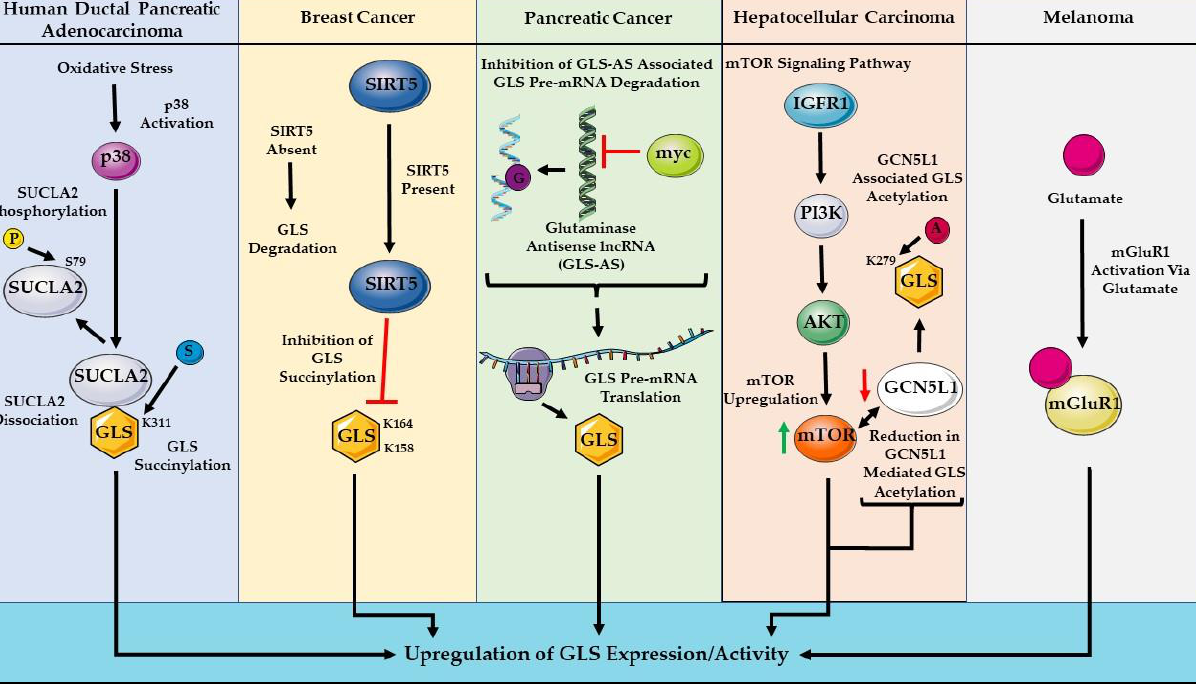
Figure 4. Known regulators of GLS expression/activity in different cancers. Symbols P, S, A, and G represent phosphate, succinyl, acetyl group, and GLS-AS protein, respectively. The black arrows indicate the series of events occurring in the cellular signaling pathways in various cancer types leading to the upregulation of GLS expression/activity. The red arrow next to GCN5L1 indicates a decrease in activity. The green arrow next to mTOR indicates upregulation. Brackets have been used to connect two different interdependent pathways. Abbreviations: succinate-CoA ligase ADP-forming subunit beta (SUCLA2), glutaminase (GLS), sirtuin-5 (SIRT5), glutaminase antisense lncRNA (GLS-AS), insulin-like growth factor receptor 1 (IGF-R1), and general control of amino ac- id synthesis 5 like protein 1 (GCN5L1). Parts of the figure were created using pictures from Servier Medical Art. Servier Medical Art by Servier is licensed under a Creative Commons Attribution 3.0 Unported License (https://creativecommons.org/licenses/by/3.0/, accessed on 9 June 2022. 6. Discussion and Future Directions mGluRs have been extensively studied in the CNS, with vast numbers of agonists and antagonists having been developed to modulate mGluR function/activity. These studies have provided a strong foundation for our understanding of mGluR functions and created numerous potential candidates for targeting mGluR signaling in cancer. A systematic high-throughput screen of these agonists/antagonists may uncover potential novel therapeutic approaches to cancer. Our findings on elevated extracellular gluta- mate in conditioned media of mGluR1-expressing tumor cells led us to examine known compounds that modulate the export of glutamate and functionally regulate the for- mation of glutamate from glutamine. We showed that the inclusion of riluzole, an inhib- itor of glutamate export, and/or CB-839, an inhibitor of glutaminase, in the growth me- dia led to a reduction in cell growth and subsequent tumor progression in vitro and in vivo [39,68]. The application of riluzole has shown promise in melanoma, breast cancer, glioma, prostate cancer, and kidney cancer [39,89,97,101,119,121,177 – 179]. Our lab and others have provided pre-clinical data that support the combination of riluzole/troriluzole with dif- ferent therapeutic approaches that target different oncogenic pathways: oxidative stress/genomic instability ( γ -radiation therapy or PARP inhibitors), cell metabolism (CB- 839), and angiogenesis/metastasis (anti-VEGF treatments or inhibitors for exosome biogene- sis and secretion) [28,57,68,69,119,178 – 183].